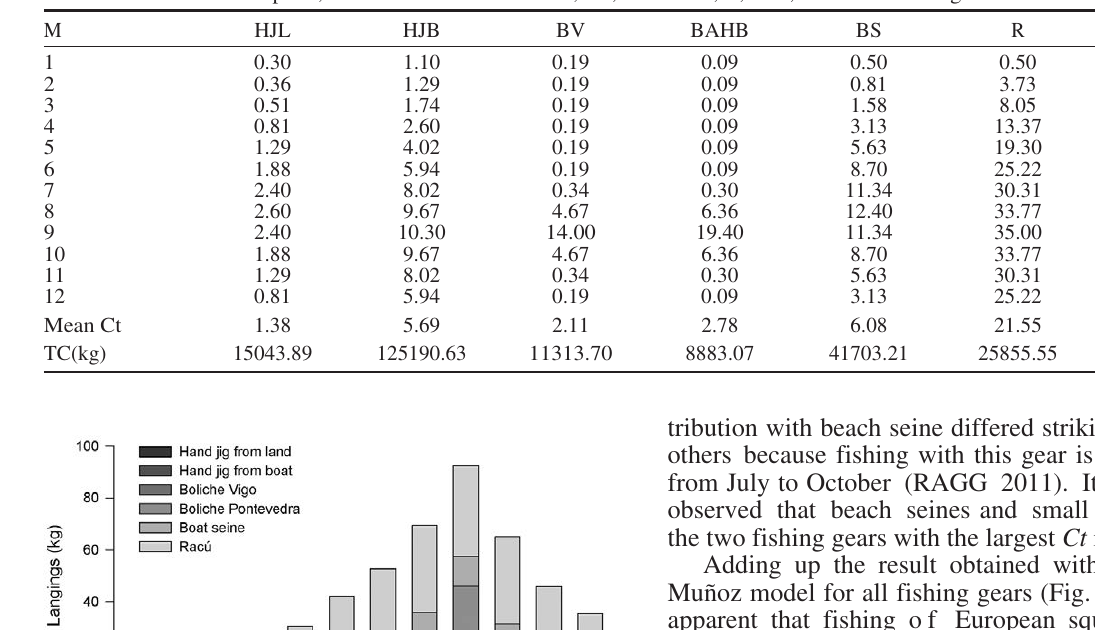
Table 3. – Loligo vulgaris . Ct (kg of squid per trip or CPUE) results of the Gómez-Muñoz model for each fishing gear and TC estimated in kilograms (kg). M, month; HJL, hand-jig from land; HJB, hand-jig from boat; BAHB, boliche from Aldán-Hio and Bueu fishing ports; the boliche is a beach seine; BS, boat seine; R, racú , which is a small gillnet.